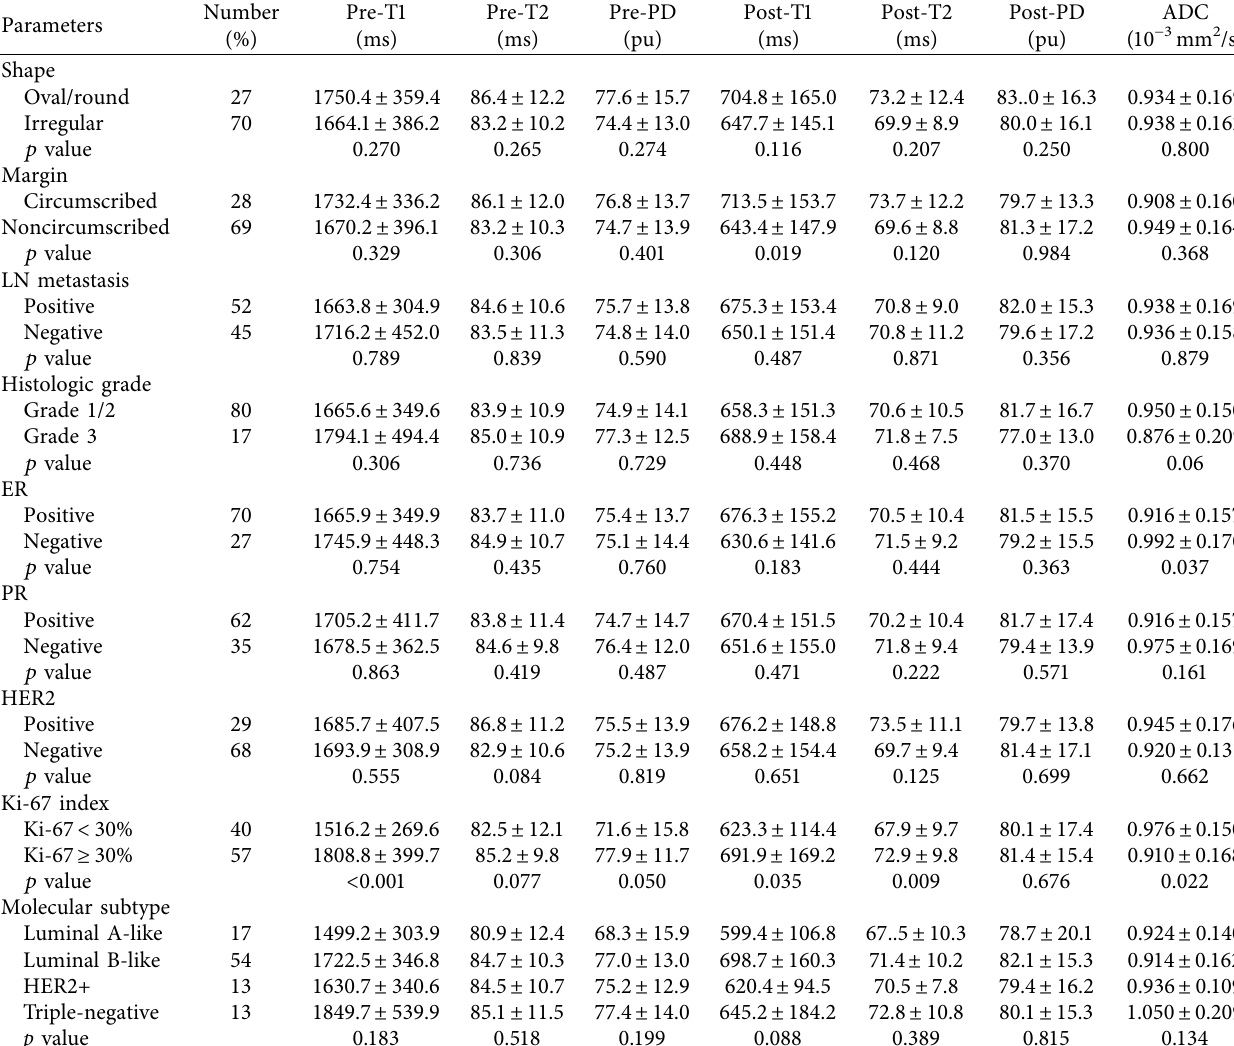
Table 3: Histopathological and imaging fndings of tumors and their associations with the quantitative parameters generated from SyMRI and DWI.